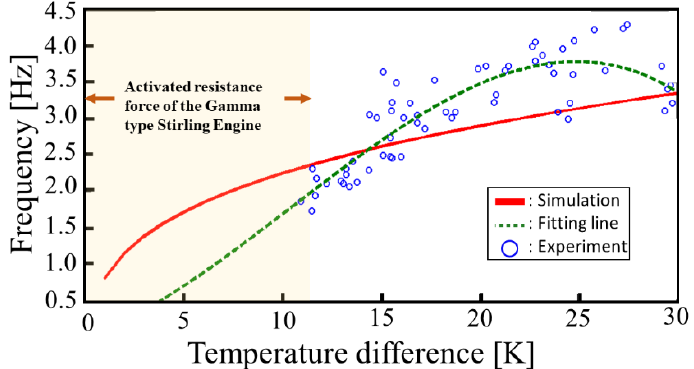
Figure 7. Relationship between the temperature difference of the Stirling engine and the frequency of the wheel. Small circles represent the experimental data, solid line the simulation data, and dotted line the fitting line with the cubic equation.